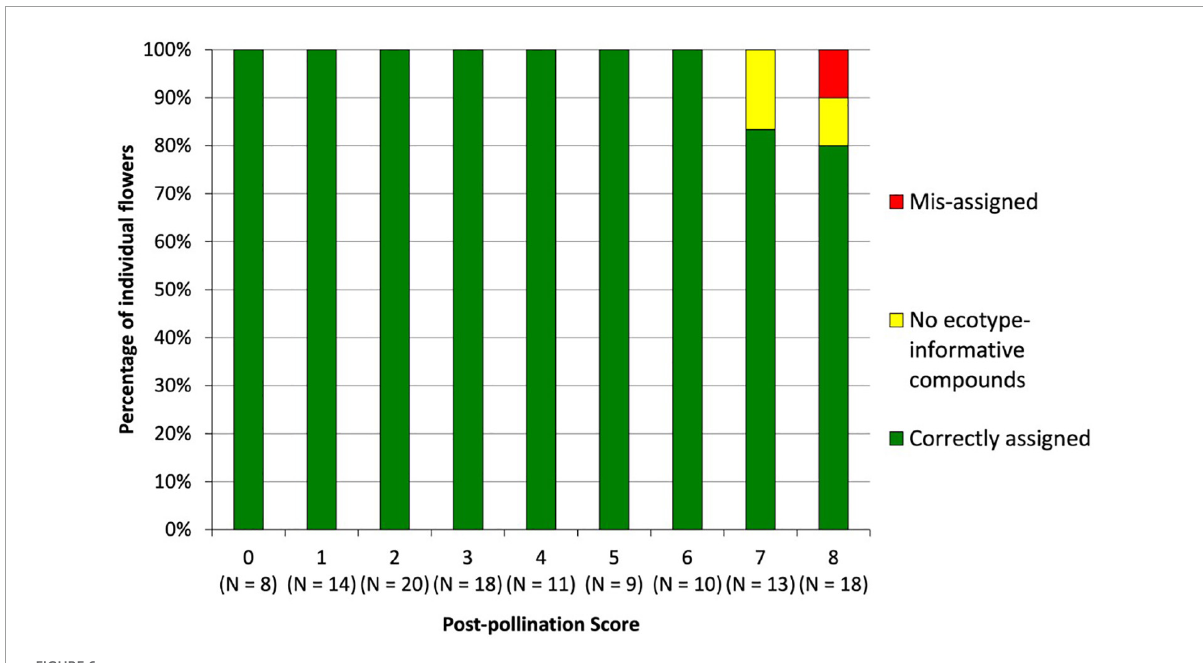
FIGURE6 Percentage of individual extracts correctly assigned based on a match with pollination data (green), containing no ecotype-informative compounds (yellow), and miss-assigned (red) by post-pollination score.